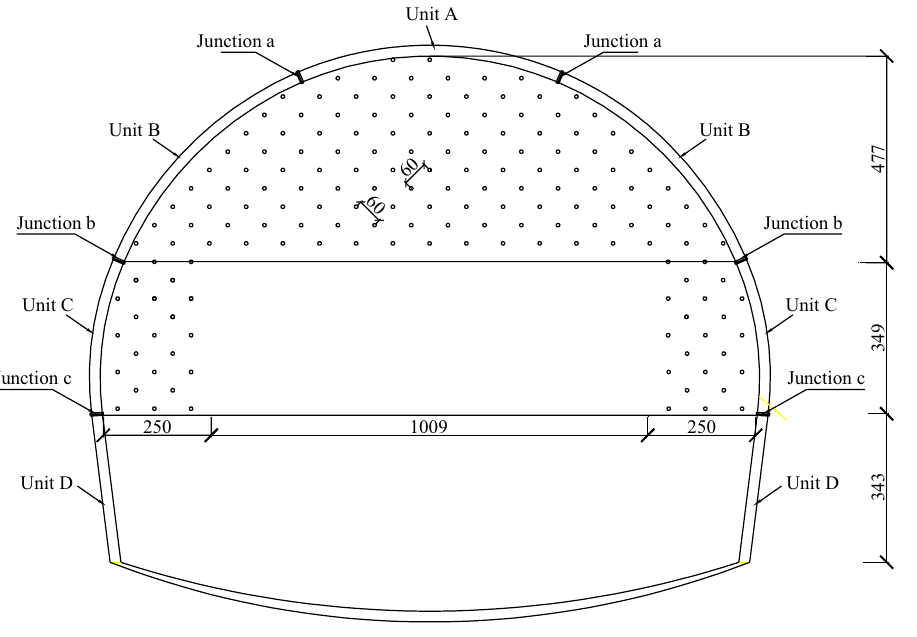
Figure 9. Arrangement of the fiberglass bolts within the excavated face.